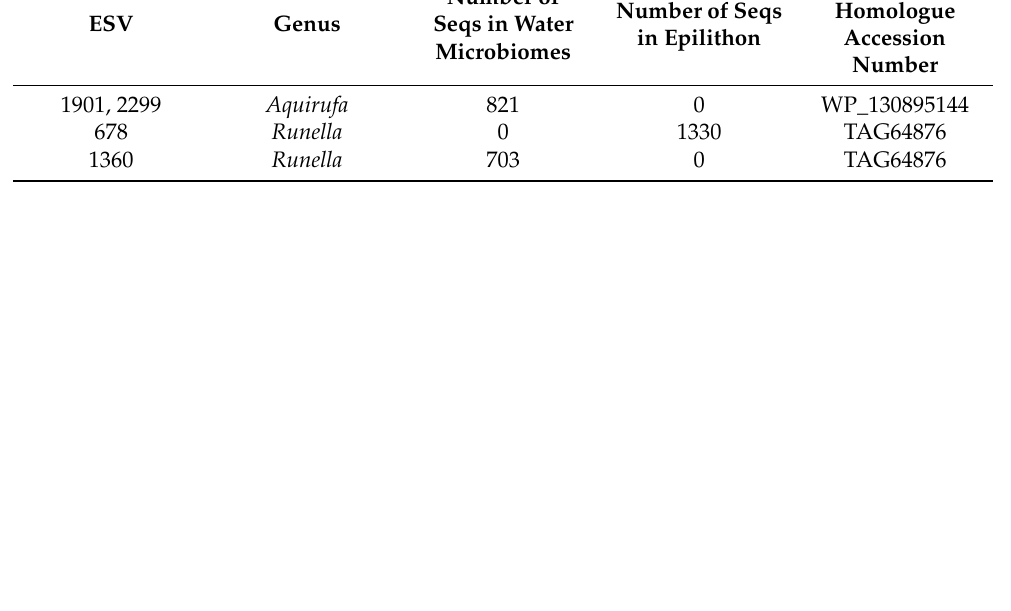
Number of Seqs in Water in